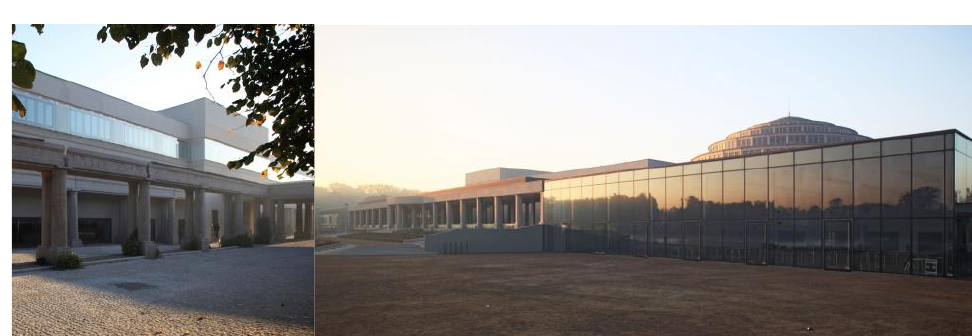
Figure 7. Renovation and refurbishment of the restaurant pavilion of the Centennial Hall complex in Wroclaw — windows and glazed curtain wall (photographs by the Authors). Table 4. The thermal modernisation building solutions for the restaurant pavilion in the Centennial Hall complex [elaborated by the Authors based on 21].